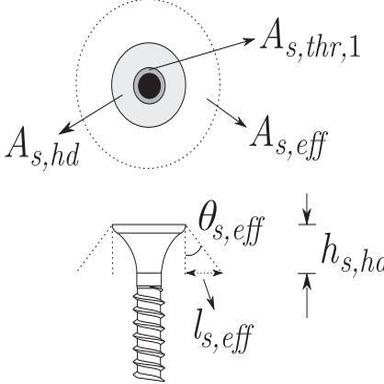
Screw connector geometry and bearing pull-through areas.